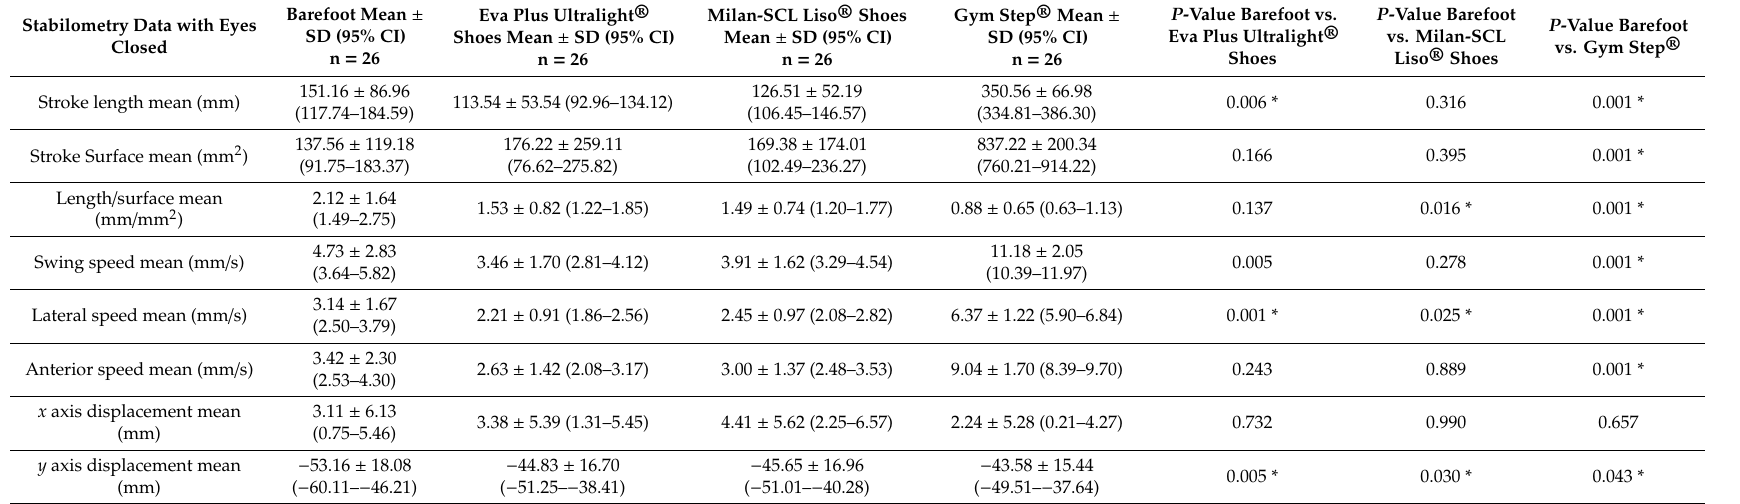
Table 9. Comparison of the stabilometry data with eyes closed between